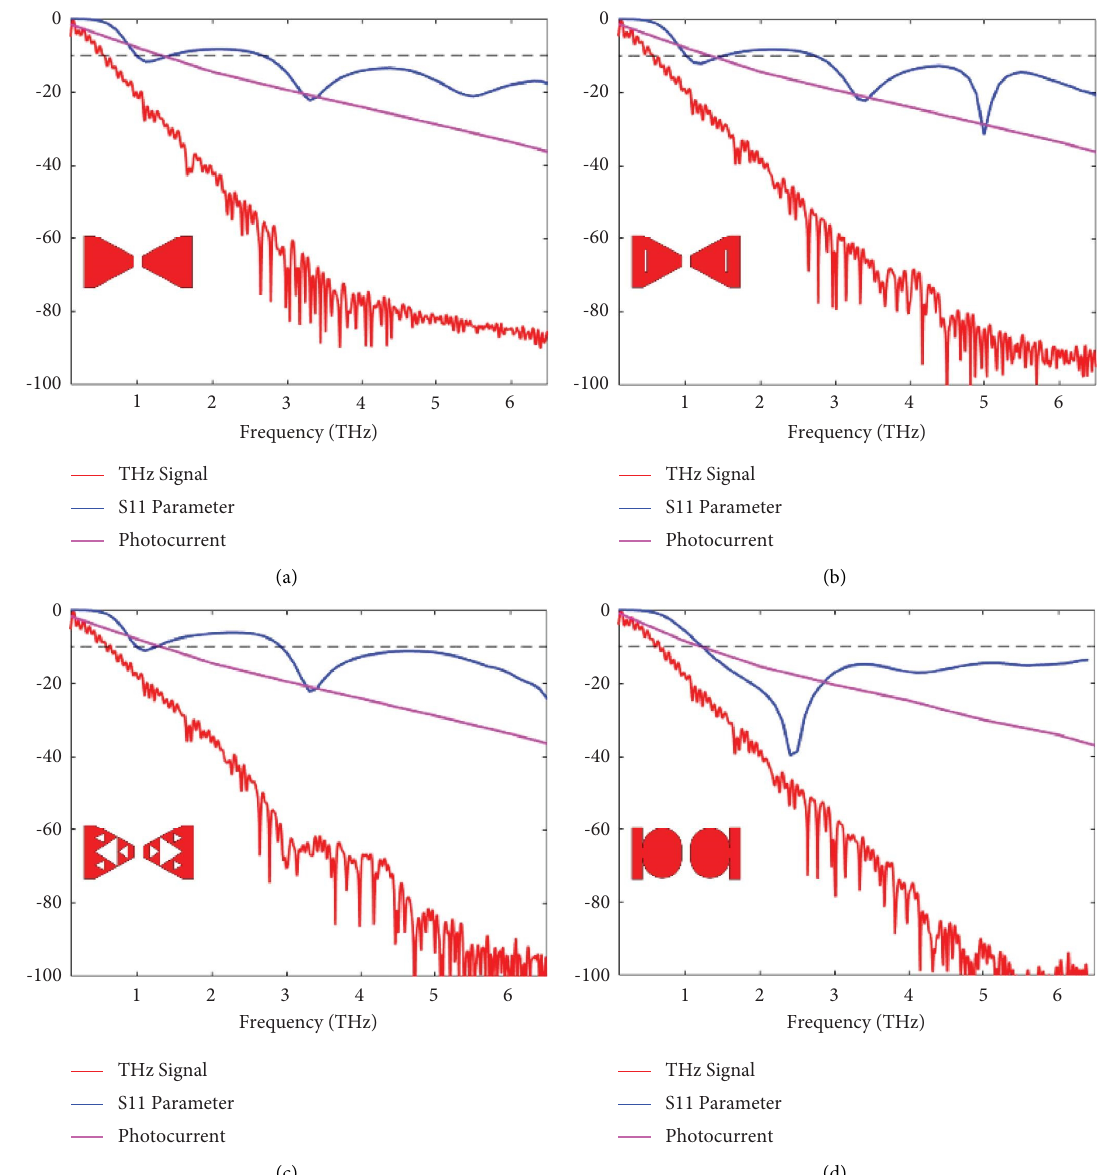
Figure 12: Analysis of overall bandwidth of measured THz signal based on the calculated S current density for (a) bowtie, (b) slotted, (c) fractal, and (d) circular PCAs. Dashed line represents the − 10dB value. All generated THz signals in the fgures are obtained through experimental